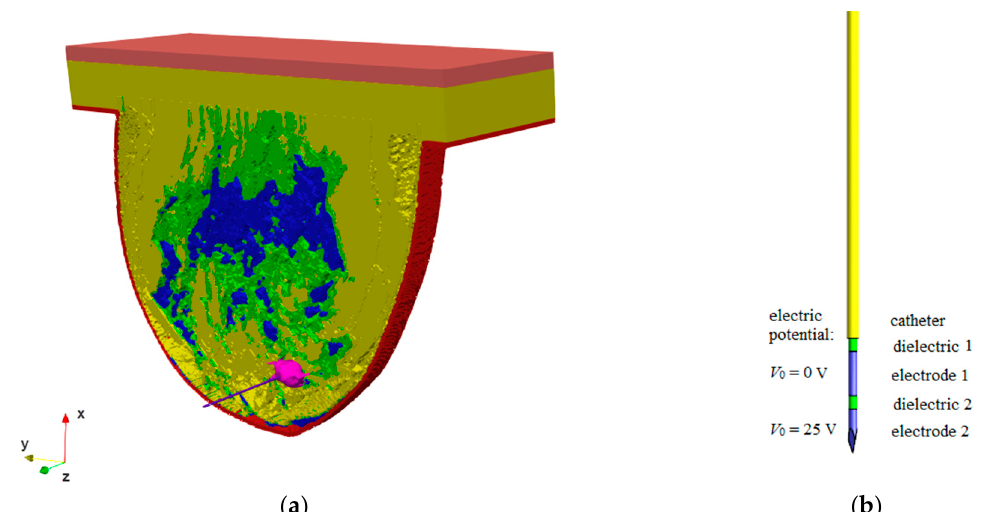
Figure 4. Model of ( a ) an RF applicator inserted into the irregular breast tumor, and ( b ) the internal structure of the needle including two electrodes in different electric potential conditions, dielectric, and external catheter.